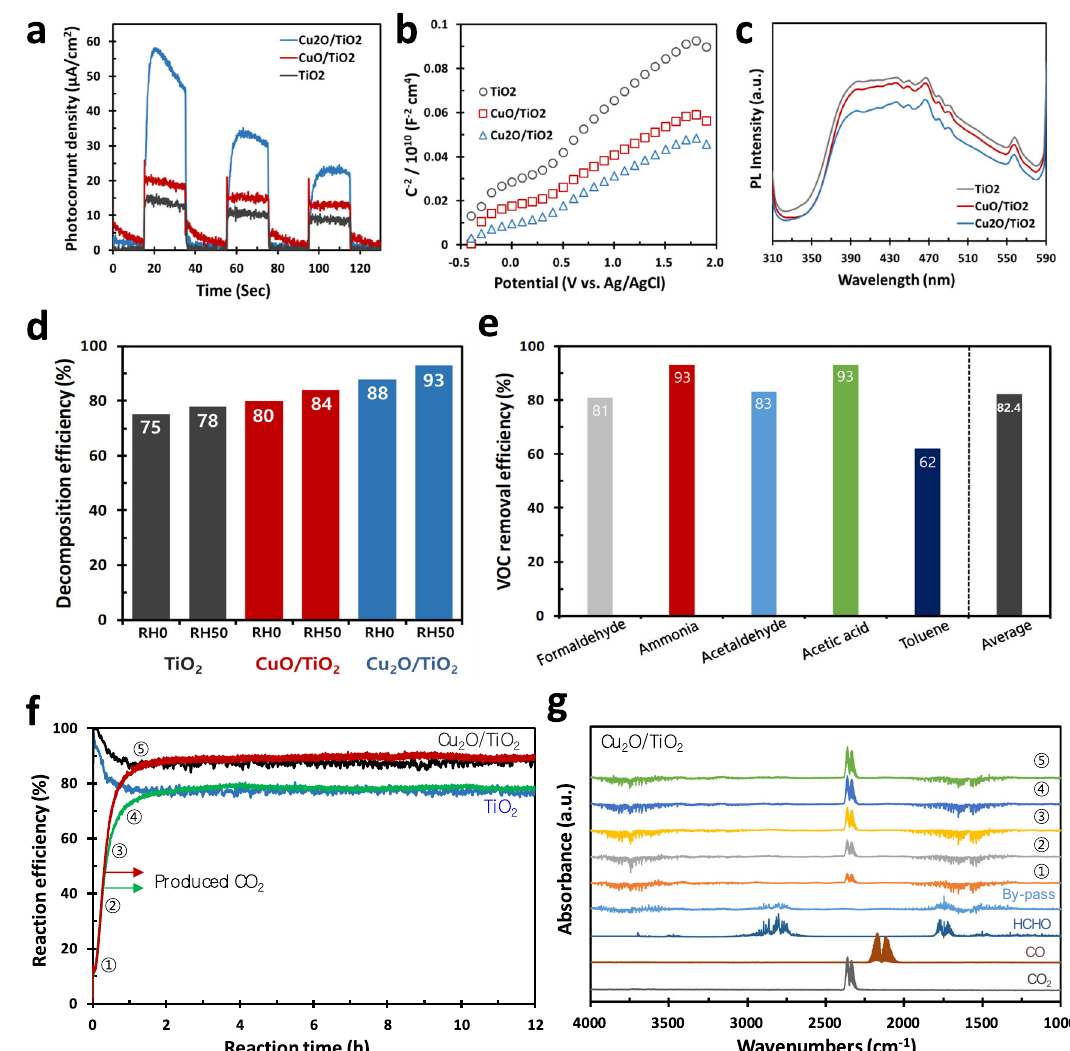
Fig. 3 | Synthesis of Cu 2 O/TiO 2 photocatalysts. a Photocurrent density by chronoamperometry: using 1 LED with a power density of 50mW/cm 2 (365nm) at 0.5V (vs.Ag/AgCl). b Charge carrier density (cm − 3 ) analysisby Mott – Schottky plot: 3.06×10 20 cm − 3 for Cu 2 O/TiO 2 , 2.81×10 20 cm − 3 for CuO/TiO 2 , and 1.73×10 20 cm − 3 for TiO 2 at fl at band potential (E FB ) of − 0.4V. c Photoluminescence: 300-nm exci- tation by UV and response emission of 310 to 590nm on the powder